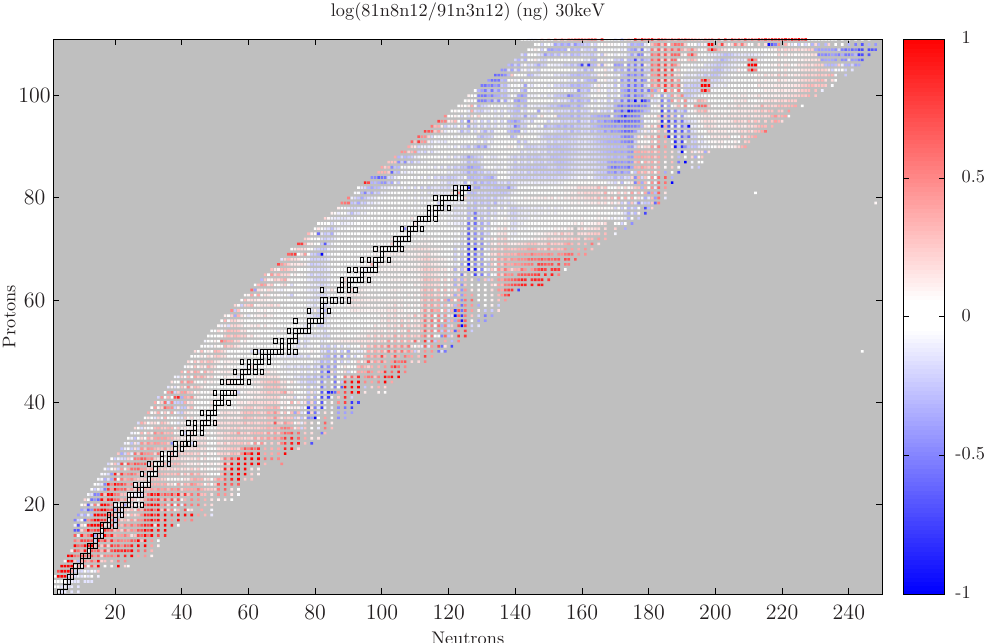
Figure 4: Ratios of model set 81n8n12 over the default TALYS model set 91n3n12 for the neutron capture cross sections at 30 keV. The color scale is the log of the ratio.